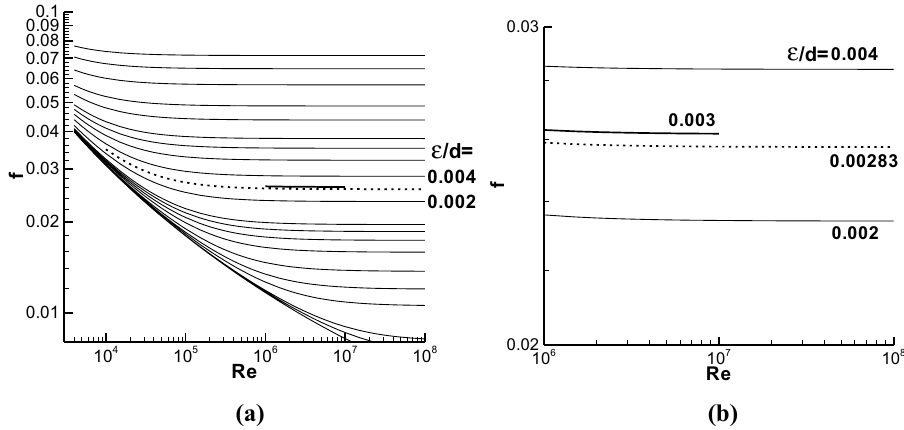
Figure 1. ( a ) A possible error when reading the Moody chart. The relative roughness ε/ds of the lines from the top to the bottom are 0.05, 0.04, 0.03, 0.02, 0.015, 0.01, 0.008, 0.006, 0.004, 0.002, 0.001, 0.0008, 0.0006, 0.0004, 0.0002, 0.0001, 0.00005, 0.00001, 0.000005, and 0.000001 respectively, as used in the Moody chart. The friction factor at ε/d = 0.003 is denoted by bold line, and the dashed line is a pseudo f curve at ε/d = 0.003. ( b ) Enlarged figure on the friction factors at ε/d = 0.004, 0.003, 0.00283, and 0.002. The original data is from ( a ).